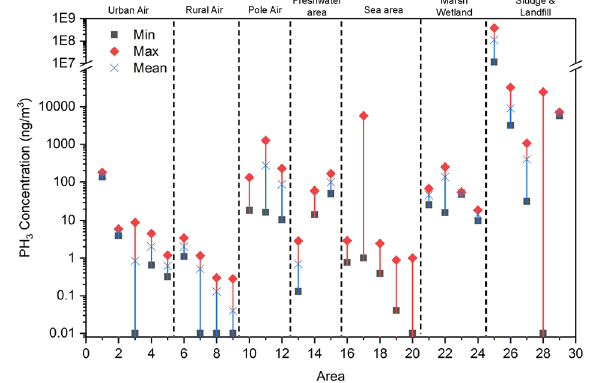
Fig. 1 Survey of the presence of free phosphine in the environment. (Urban air 33 : 1. Berlin, 2. Leipzig, 3. East Leipzig, 4. Hamburg, 5. Buenos Aires; Rural air 33 : 6. Leipzig, 7. Hammamet, 8. Israel, 9. Namibia; Pole air 7,27,34 : 10. Arctic Yellow River station, 11.